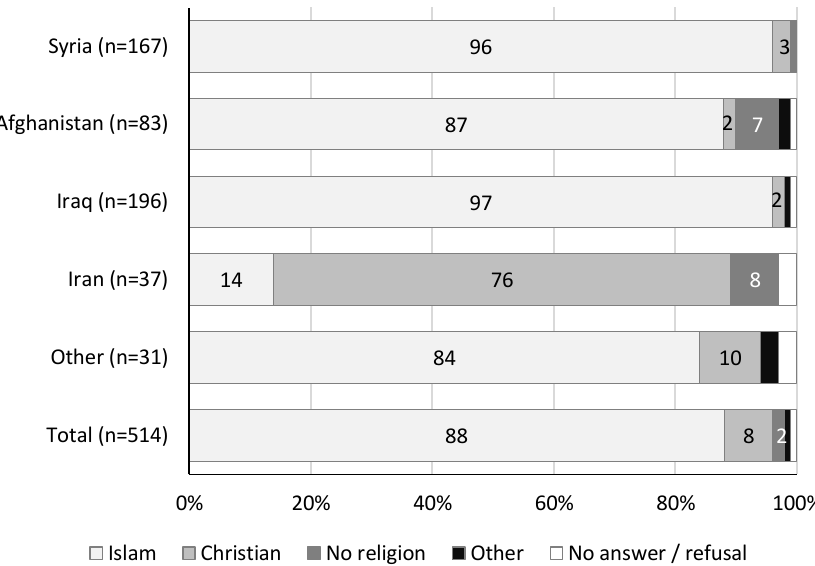
Figure 2. Religious affiliation of DIPAS#1 respondents by citizenship. Source: DiPAS#1 ( n = 514 persons, among them 196 from Iraq, 184 from Syria, 83 from Afghanistan, 37 from Iran and 31 with other citizenship.